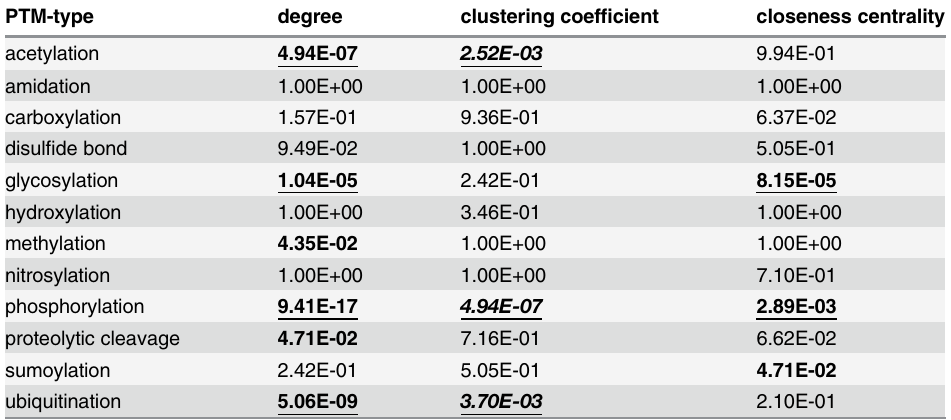
Protein sets were sorted in descending order of the respective PIN-property and the top/bottom 25% tested for overlap with human disease genes reported in OMIM (http://www.ncbi.nlm.nih.gov/omim) based on a Fisher ’ s exact test with FDR-correction with respective counts of proteins binned according to binary decisions top/bottom 25% property and disease association yes/no forming the 2×2 contingency table. p - values highlighted red indicate signi fi cant overlap of the top-25% set of proteins for a particular network property with human disease proteins, while blue values signify larger than expected overlaps of the bottom-25% protein sets with proteins annotated to be involved in disease processes at p-value thresholds of p -value 0.05, 0.01 (if underlined), respectively. Black font color indicates no signi fi cant overlap of neither the top nor the bottom 25%